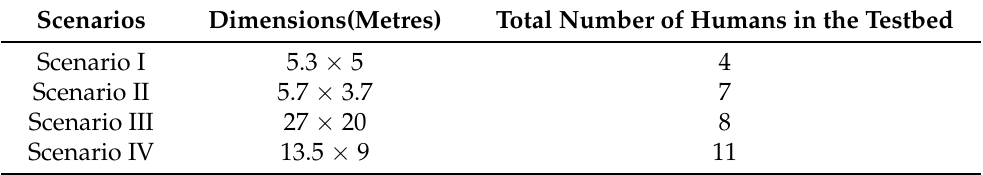
Figure 9. Generated occupancy grid maps of the work space environments for scenarios I to IV. Table 2. Experimental